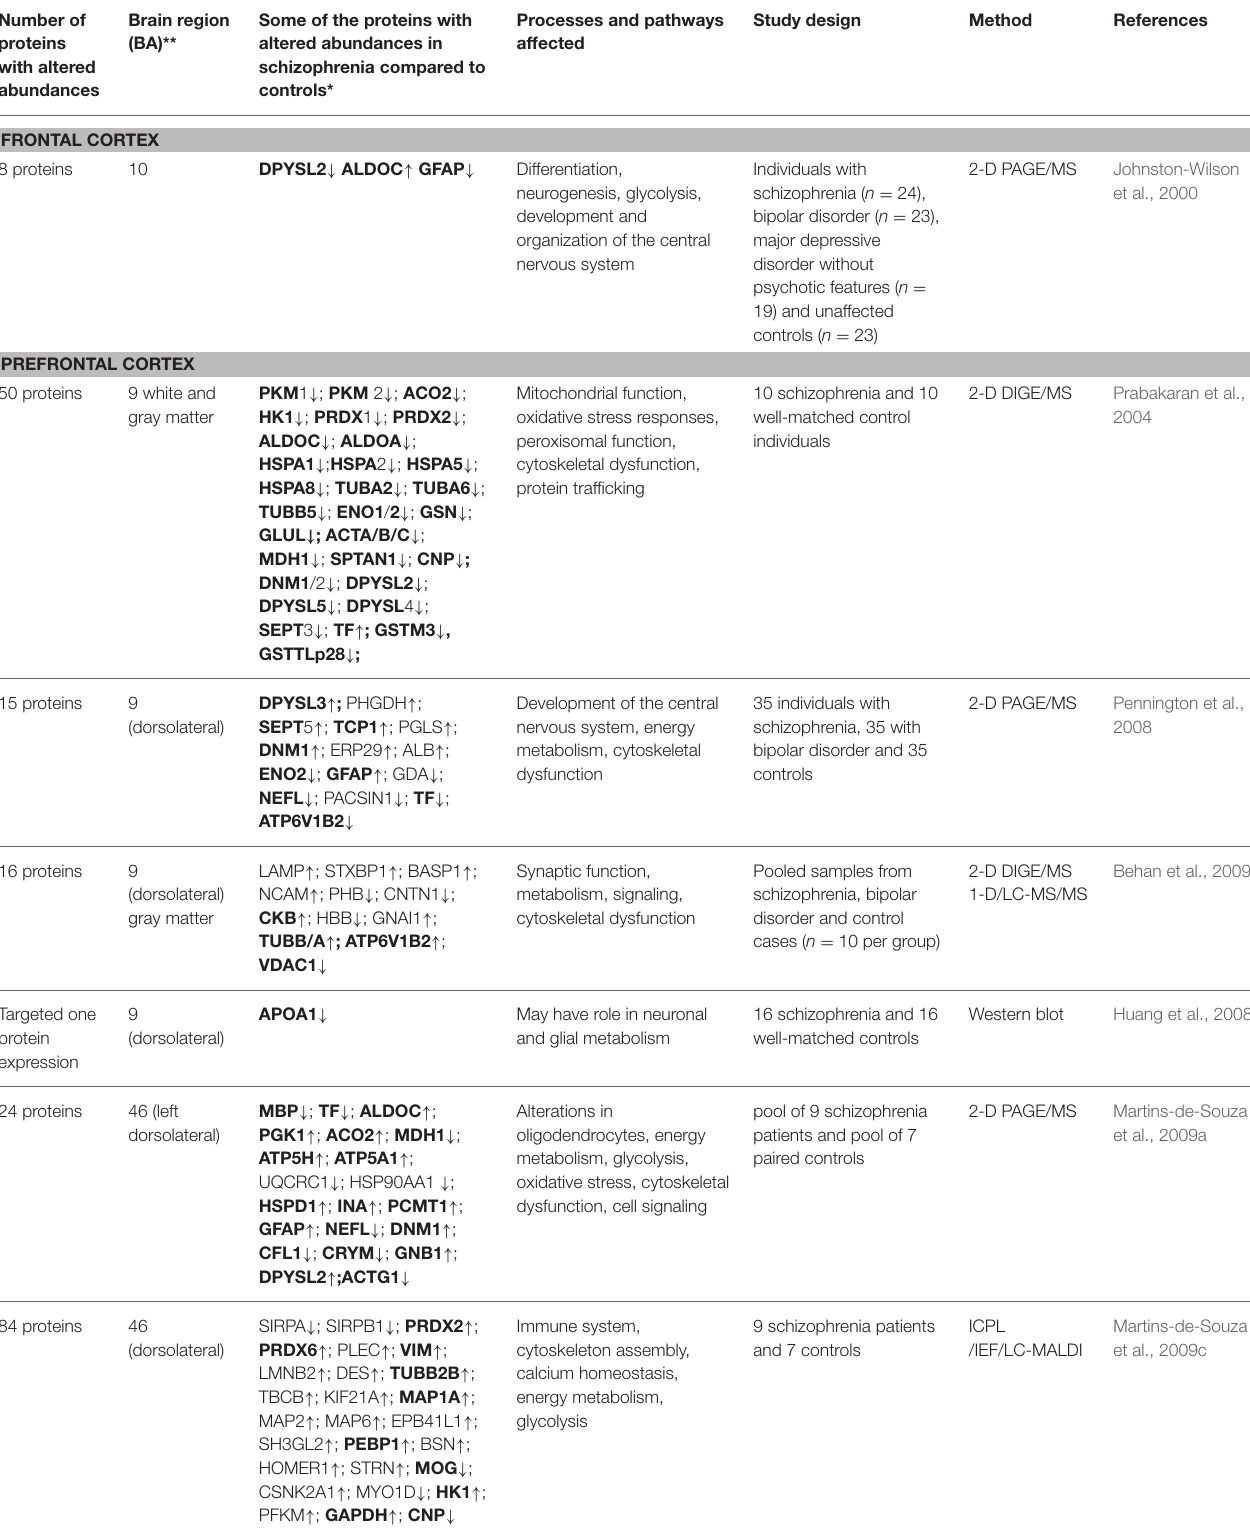
TABLE 1 | Proteins with altered abundance in schizophrenia obtained by comparative proteomics studies of several human brain regions. Number of